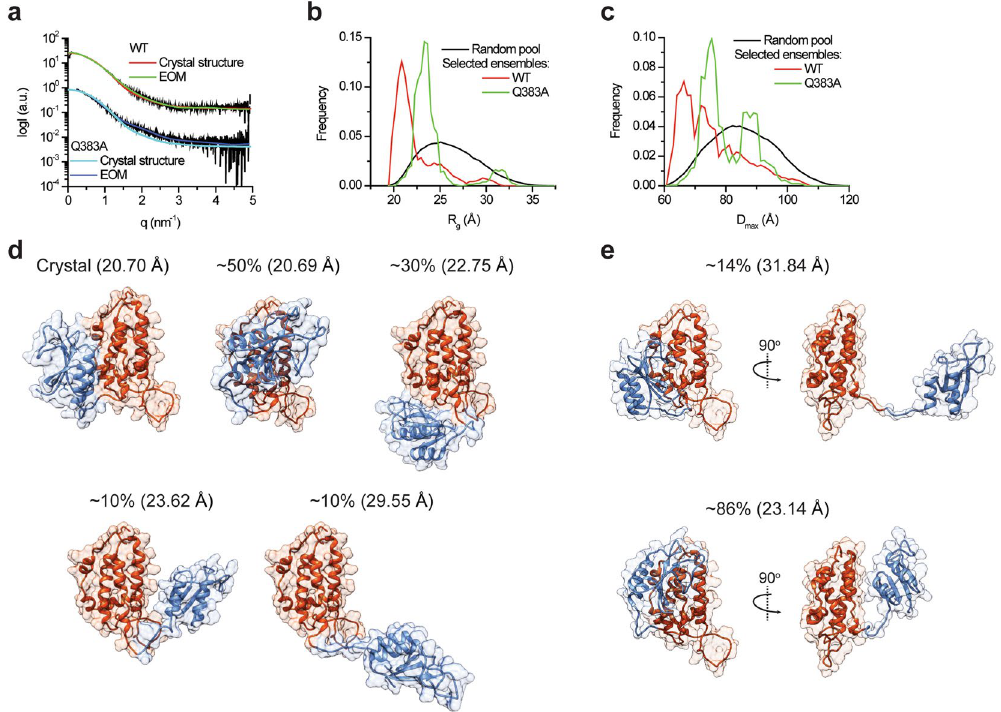
Figure 5. EOM analysis of mCLIC6. ( a ) Experimental SAXS curve of mCLIC6 (WT or Q383A; black lines) were fit using CRYSOL or EOM, as indicated. ( b ) Random Rg pool (black line) and EOM-selected ensemble distributions of mCLIC6-WT (red line) and mCLIC6-Q383A (green line). ( c ) Random D max pool (black line) and EOM-selected ensemble distributions of mCLIC6-WT (red line) and mCLIC6-Q383A (green line). ( d,e ) Representative conformations of mCLIC6-WT ( d ) and mCLIC6-Q383A ( e ), found in the crystallographic and EOM analyses. The relative frequency of each conformation in the EOM analysis is indicated along the model Rg in parentheses. The TRX and α domains are presented as blue and red cartoons,